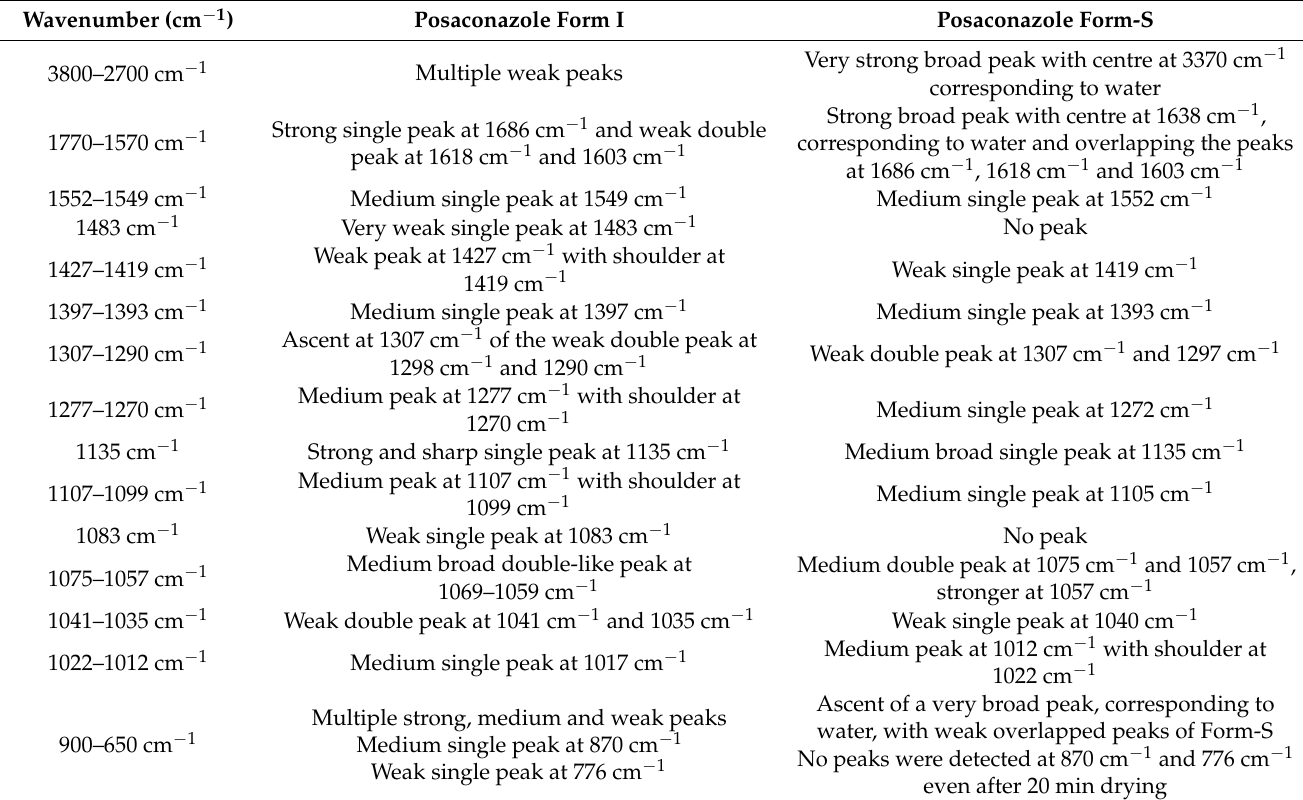
Table 5. Differences between the ATR spectra of posaconazole Form I and posaconazole